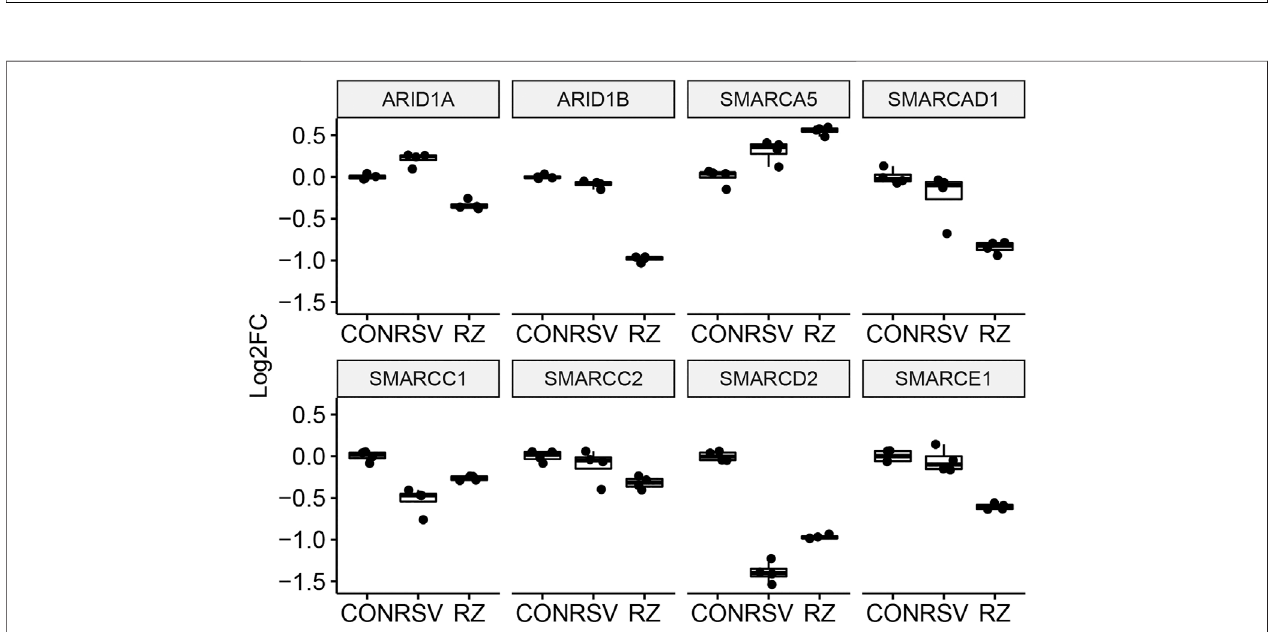
FIGURE 8 | BRD4 modulates the expression of SMARC complexes. mRNA expression of BRD4-interacting SMARC complexes. For each, log 2 FC values are plotted as 25-75% interquartile ranges. Adjusted p- values of RSV vs RSV + ZL0454 treatment are as follows: ARI1A (cid:1) 1.21E-29; ARID1B (cid:1) 2.82E-98; SMARCE1 (cid:1) 8.13E-14; SMARCD2 (cid:1) 8.37E-15; SMARCC2 (cid:1) 0.024; SMARCA5 (cid:1) 0.0014; SMARCAD1 (cid:1) 2.81E-7; and SMARCC1 (cid:1) 0.000723.